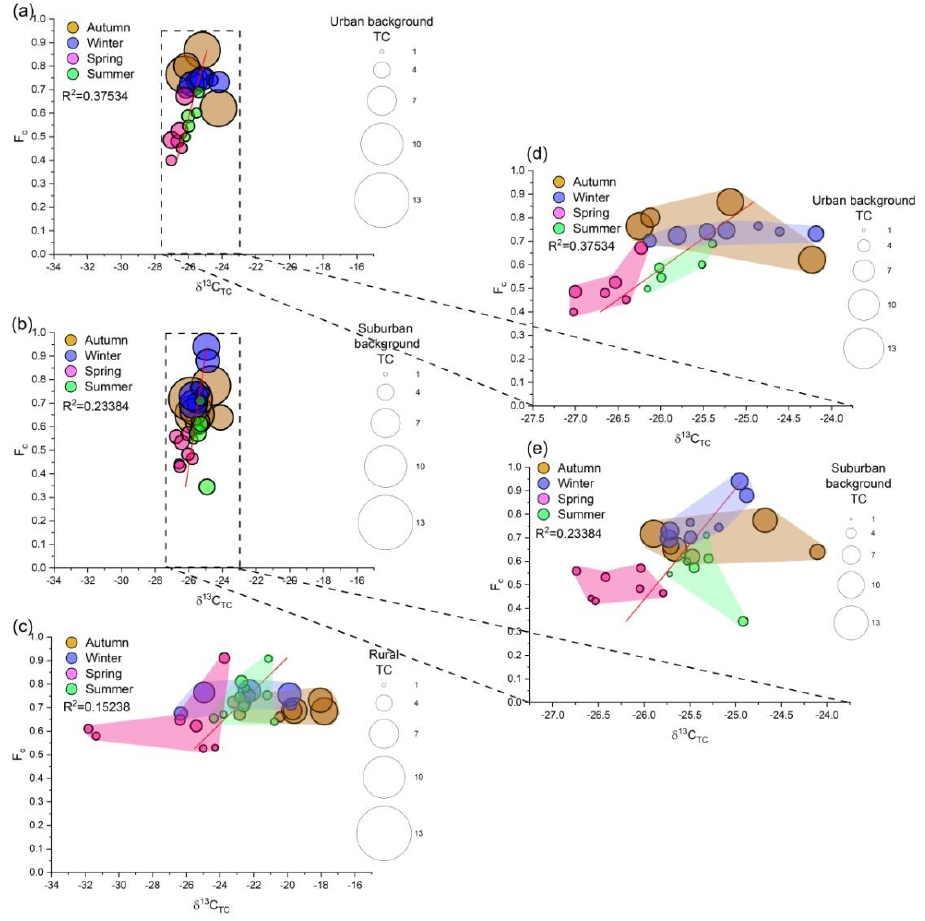
Figure 6. Seasonal clusters of the f C values depicted as a function of δ 13 C values at the urban background ( a , d ), suburban background ( b , e ) and rural sites ( c ) .